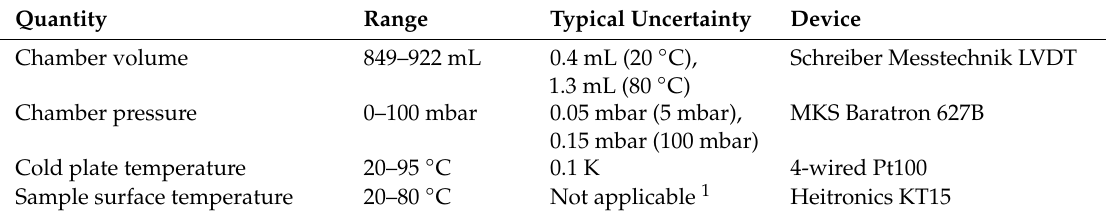
Figure 3. Sorption kinetic setup for frequency response, large temperature jump and large pressure jump experiments with absolute and differential equilibrium measurement. Absolute sorption equilibria are measured volumetrically by dosing in from the dosing chamber, differential equilibria by small temperature and pressure steps around equilibrium. Table 2. Principal characteristics of measurement quantities, details are explained in the